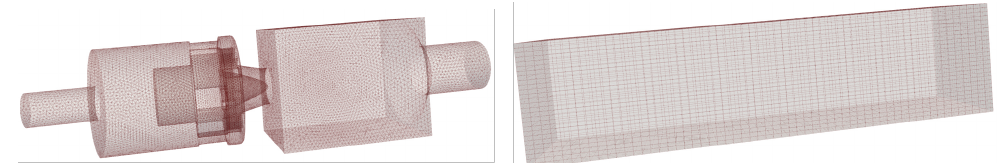
Figure 19. On the left, we find the high-fidelity mesh. On the right, we find the coarse Cartesian mesh for the Bayesian ROM, of size 60 × 28 ×